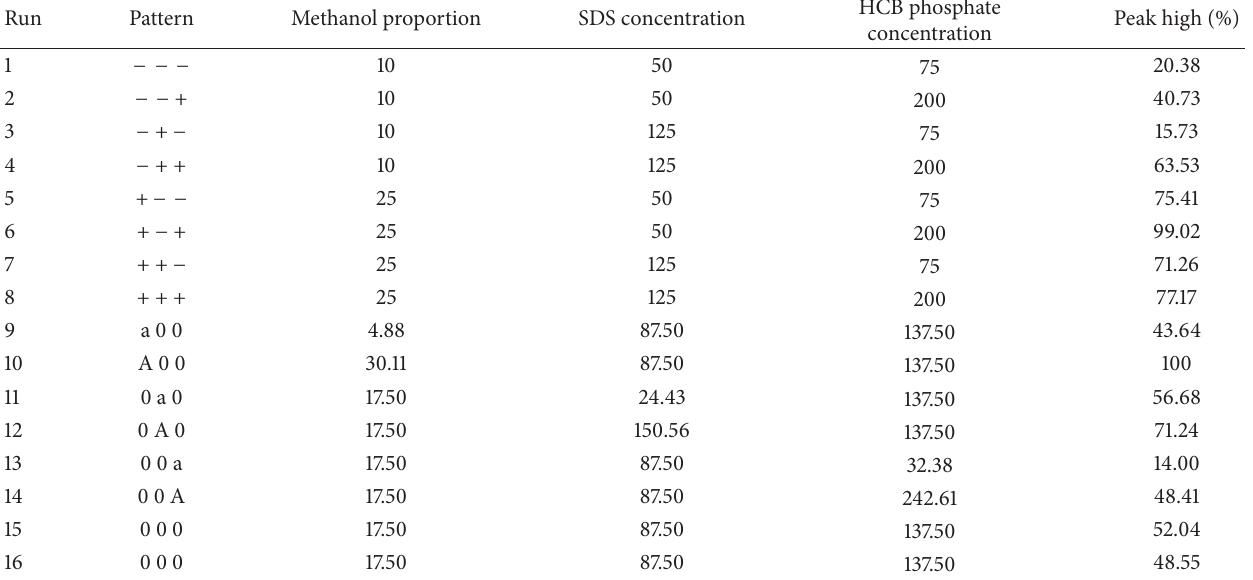
Table 2: Experimental design for CCD.